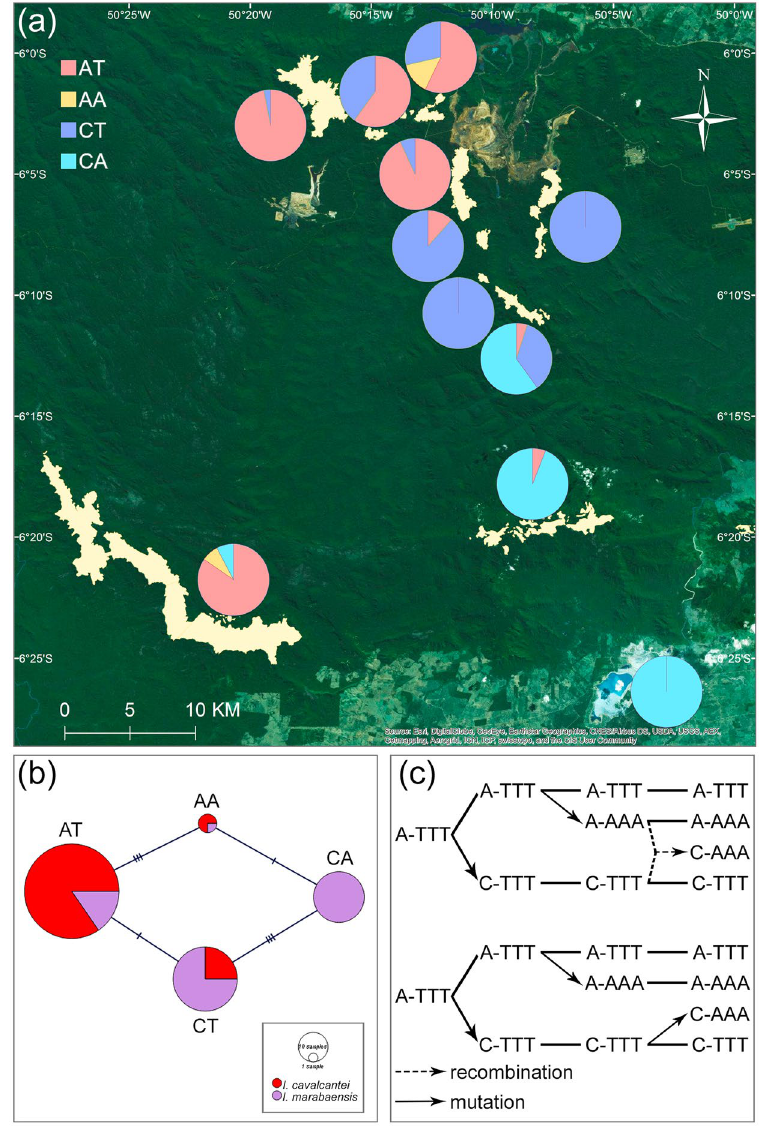
Figure 2. (a) Distribution of the four plastome types of Carajás morning glories. (b) Parsimony network of plastome haplotypes. Bars across the network edges indicate the numbers of mutational changes. (c) The mutation and recombination scenarios of plastome diversity origin among ancestors of the species. Plastome types/haplotypes are represented by polymorphic sites identified in rpoC1 (A/C SNP) and psbA-trnH (AAA/ TTT SNP stretch) sequences. Dash is a several thousand base pairs long gap between the genes. Plastome AT (A-TTT) was arbitrary chosen as